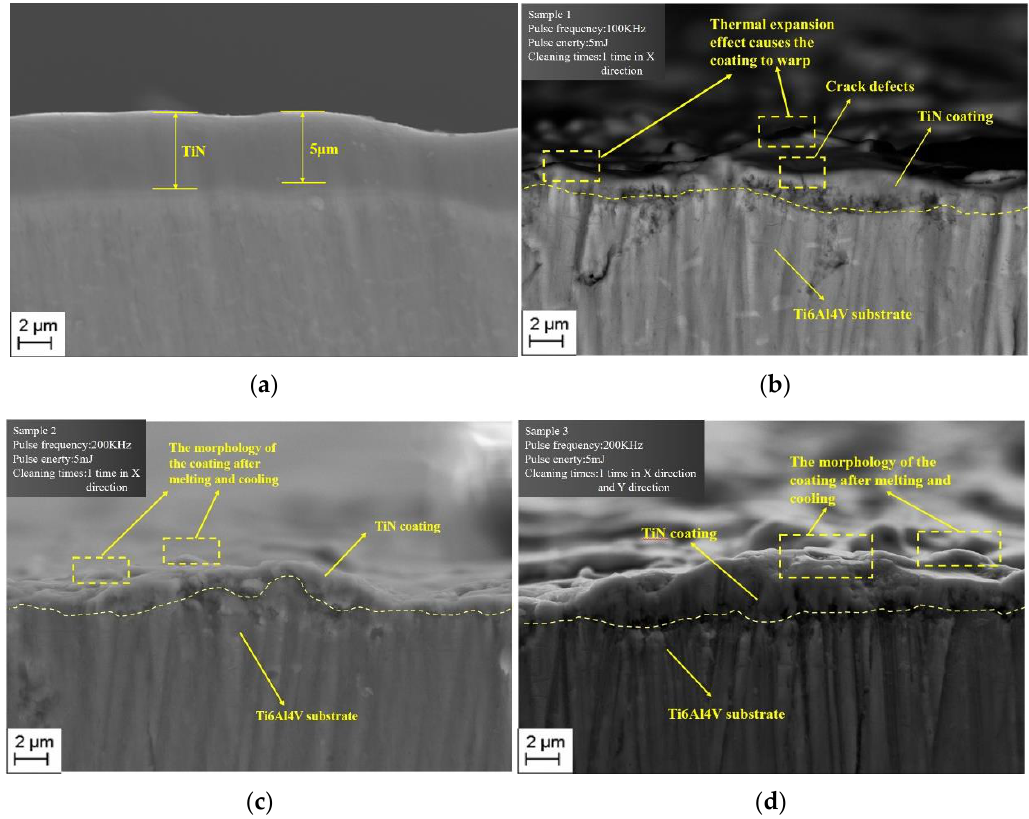
Figure 4. Section of the interface between the coating and the substrate: ( a ) before laser cleaning, ( b )